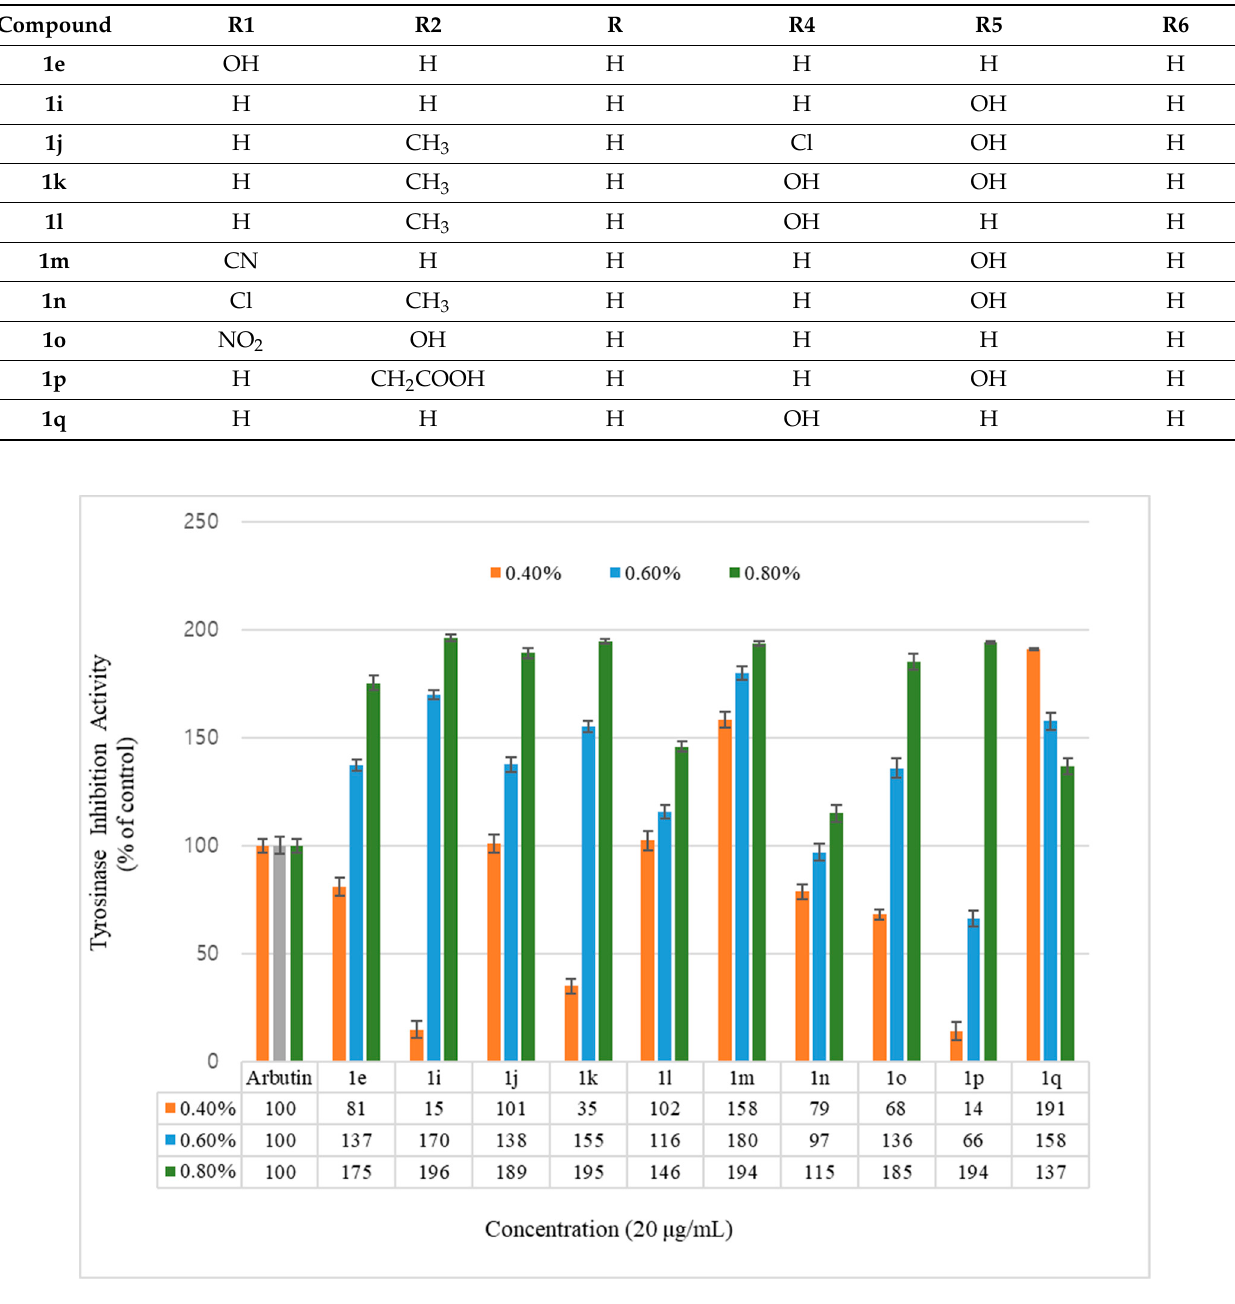
Figure 3. Mushroom tyrosinase activity effects of geranyloxycoumarin derivatives and reference. Results are expressed as means ± SEMs.